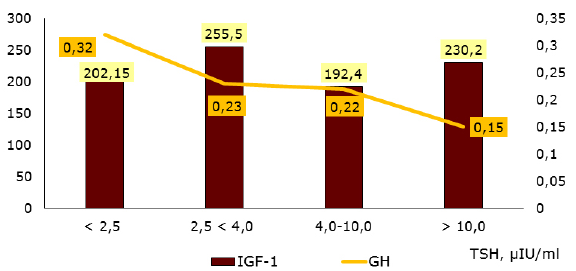
Figure 4. Indicators of GH and IGF-1 in pa- tients with type 1 diabetes depending on